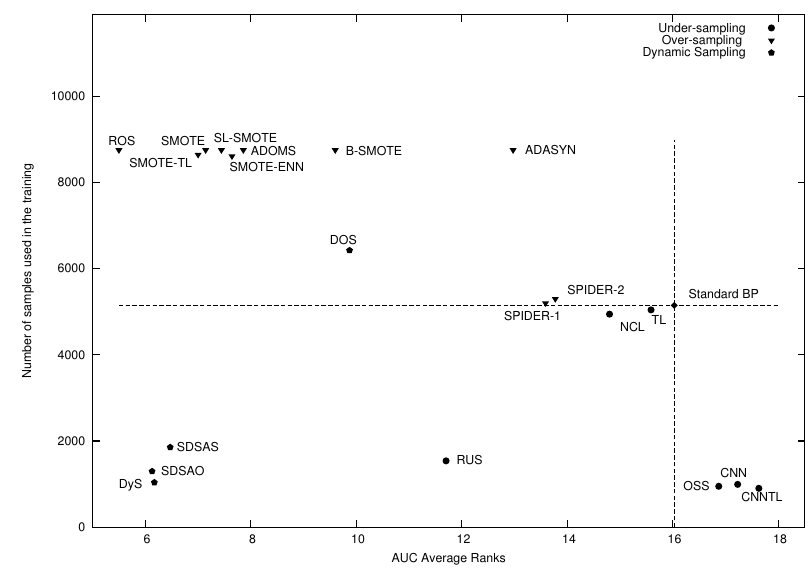
Figure 2. Number of samples used in the training process by the studied methods in contrast to the Area Under the receiver operating characteristic Curve (AUC) average ranks obtained in the classification test. The x axis represents the average ranks (the best performing method should have the rank of one or close to this value). We previously used the ten-fold cross-validation method. The number shown in the y axis corresponds to the average training fold